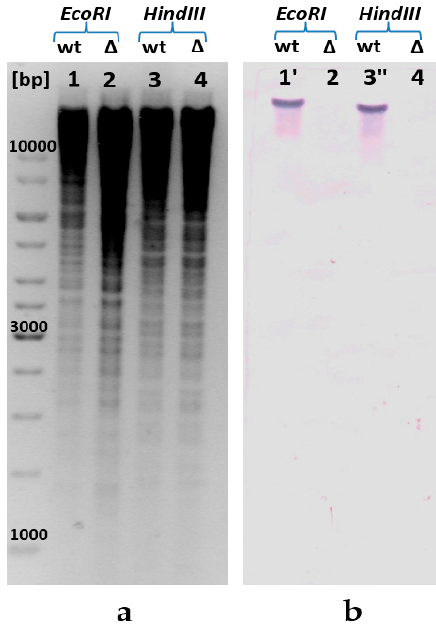
Figure 2. Confirmation of the presence of ppa deletion in the E. coli chromosome by Southern blot analysis: ( a ) for the Southern blot analysis, genomic DNA was digested with EcoR I (lanes 1, 2) and Hind III (lanes 3, 4), and ( b ) hybridized with a ppa -carrying DNA fragment amplified by PCR. The calculated size of the ppa -carrying EcoR I-fragment is 18,447 bp (1 ′ ); calculated size of ppa -carrying Hind III fragment is 16,618 bp (3 ′ ’). [bp],DNA ladder; wt, wild-type MG1655; ∆ —MG1655 IS 5.8-P L - hppa Rru ∆ ppa :: cat .